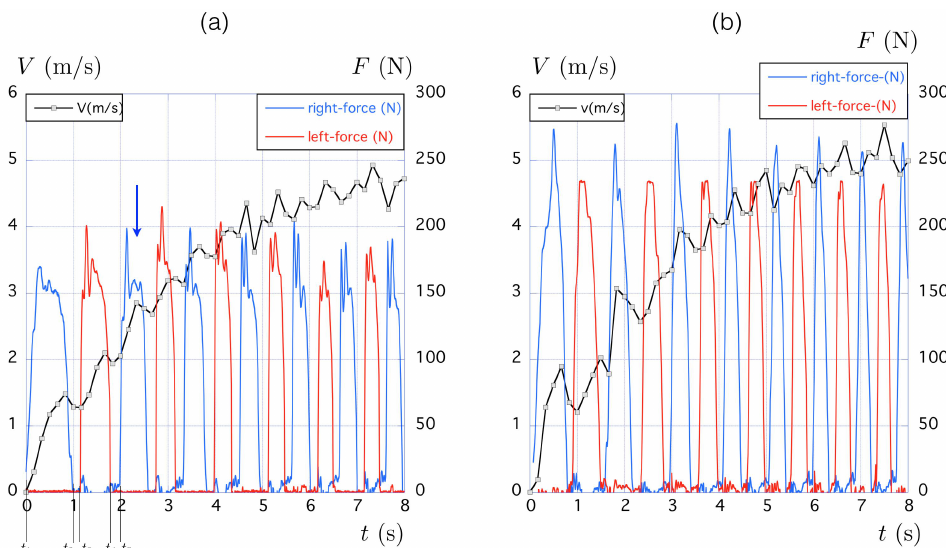
Figure 9. Time evolution of the velocity (solid black line with units on the left vertical axis) and the forces (solid colored curves with units on the right vertical axis) corresponding to the chronopho- tography presented in Figure 10. ( a ) Data for Athlete A1. The blue arrow indicates the cycle that is detailed in Figure 8. ( b ) Data for Athlete A2. The blue color is used for the force measured on the right paddle while the red color is used for the left. The quantity F is the intensity of the force exerted in the direction normal to the paddle surface.